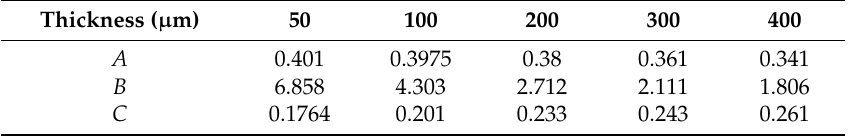
Table A1. Coefficients for different initial thickness. Table 2. Coefficients for different initial thickness.